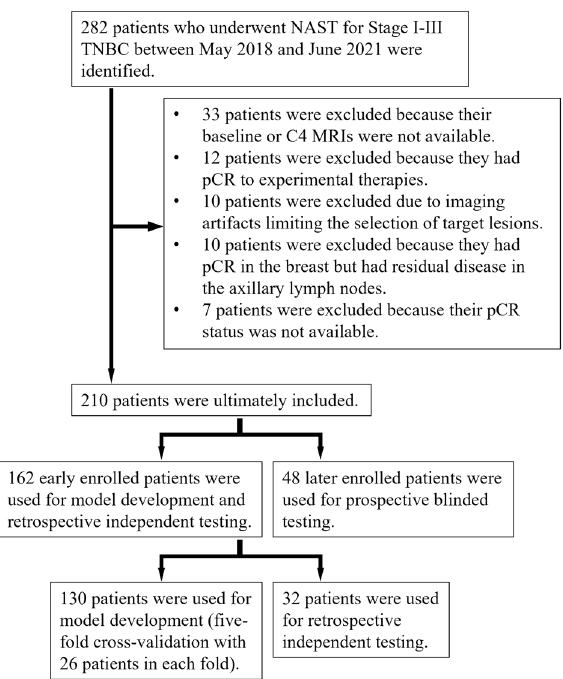
Figure 1. Patient selection. A group of 130 patients was used for model development through fivefold cross- validation. A group of 32 patients was reserved for retrospective independent testing. An extra prospective group of 48 patients was used for blinded